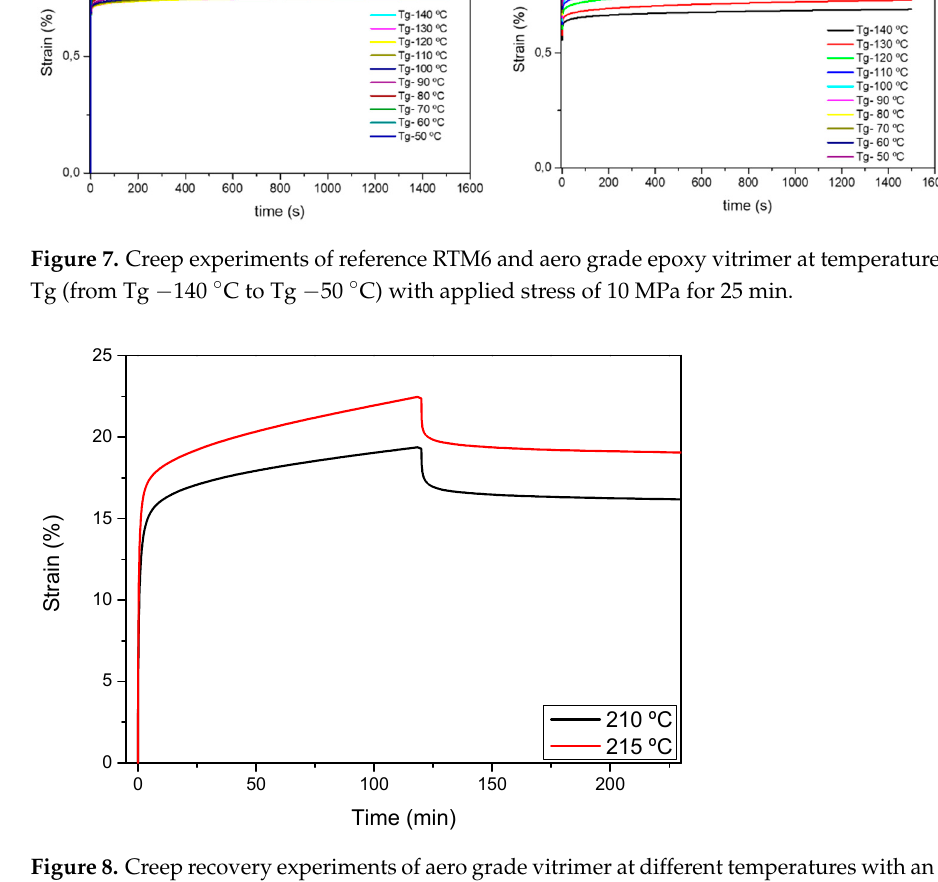
Figure 8. Creep recovery experiments of aero grade vitrimer at different temperatures with an ap- plied stress of 1